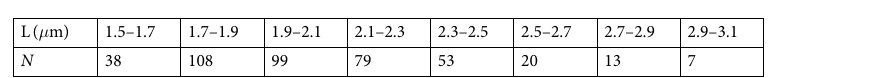
Table 1. The number of analyzed cell N , in 8 groups. Division is based on the length of the bacteria L